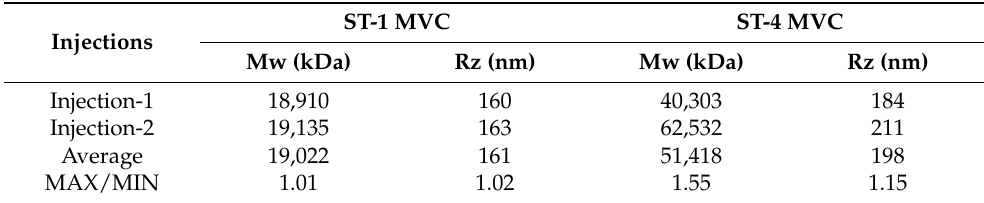
Figure 6. MVC Mw distribution on AF 4 -MALS: ( a ) ST-1 MVC; ( b ) ST-4 MVC. Each conjugate eluted out as a peak in blue trace. The Mw (molar mass) distribution across a peak was represented by a red line. Table 4. MVC Mw and Rz measured from AF 4 -MALS.